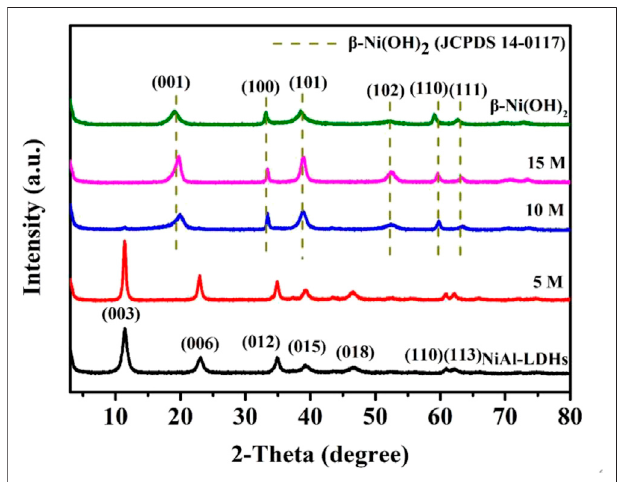
FIGURE 1 | XRD patterns of NiAl-LDHs precursor, the alkaline-etched samples in 5, 10, and 15 M KOH solution, and β -Ni(OH) 2 sample synthesized by precipitation